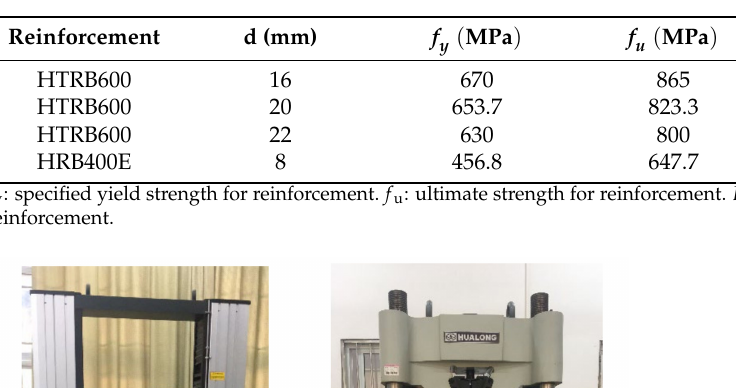
Table 2. Steel material properties.